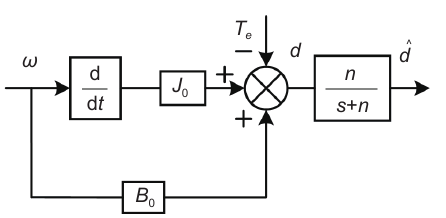
Fig. 3 Structural block diagram of ESMO.